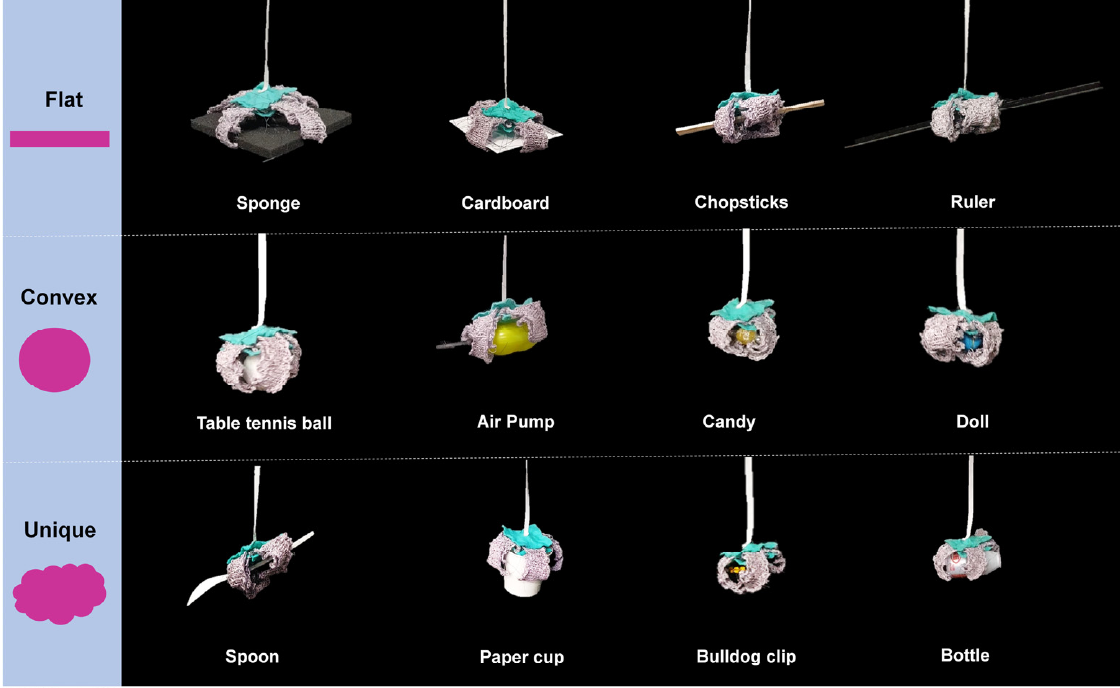
Figure 11. Gripping performance of the soft morphing textile gripper. The gripping force is main- tained when a flat (Video S3), convex (Video S4), or unusually shaped object (Video S5) is held and moved up and down.